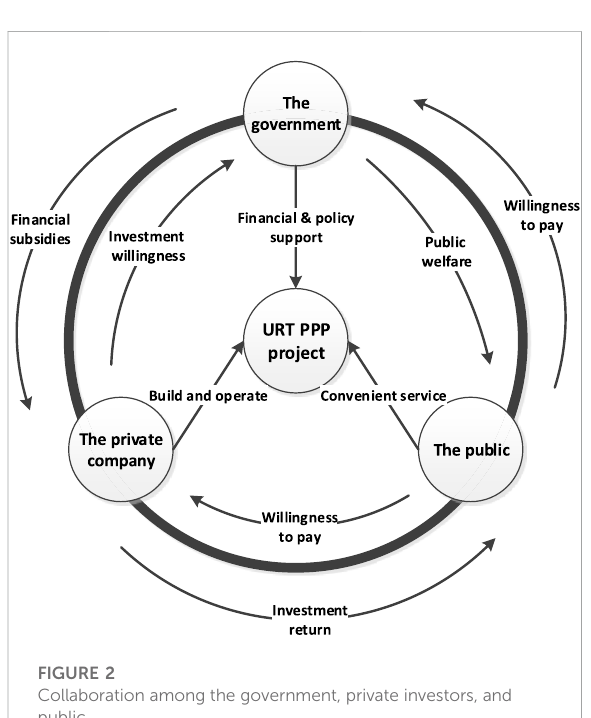
FIGURE 2 Collaboration among the government, private investors, and